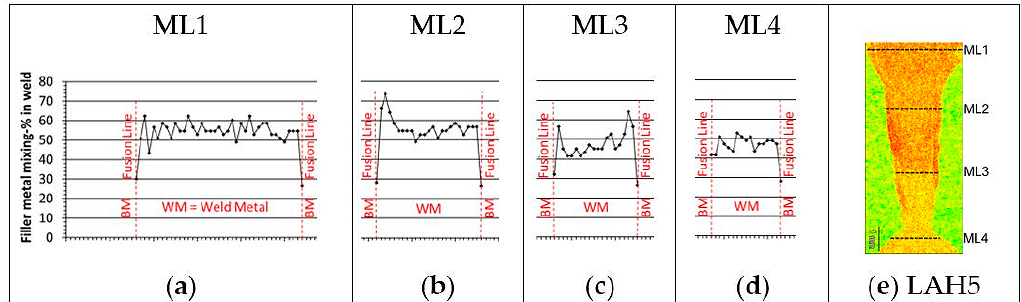
Figure 13. Filler metal mixing results from EDS stepwise characterization. ( a – d ) Filler metal mixing-% profiles of measurement lines 1–4 (ML1–ML4) from test weld LAH5 ( e ). In figures ( a – d ) one step between adjacent measurement points in the horizontal axis equals 100 micrometres.